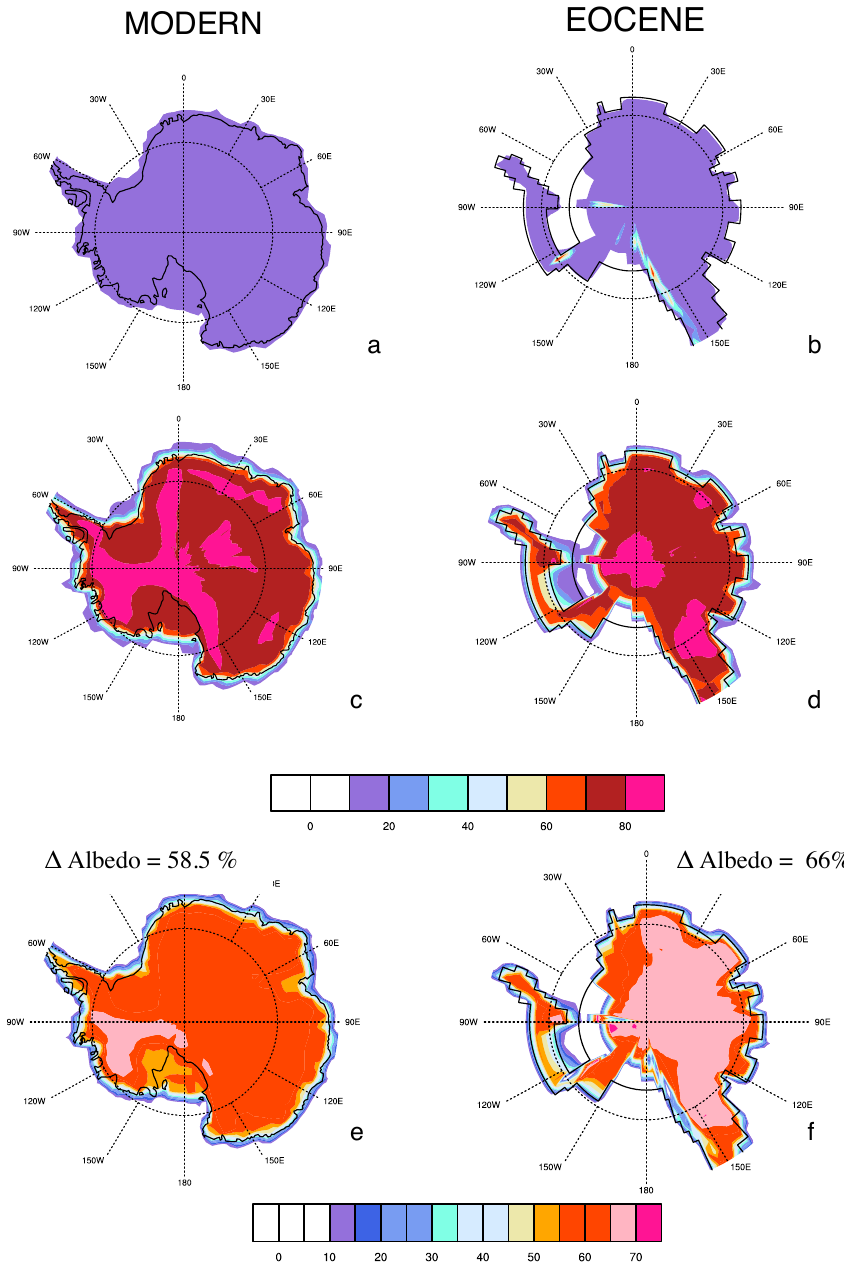
Figure 3. Surface albedos (%) for Modern and Eocene glaciated and unglaciated simulations averaged over the Fig. 3. Surface albedos (%) for modern and Eocene glaciated ( α +oro) and unglaciated simulations averaged over the austral summer at austral summer at 2240 ppm CO 2 . a) Modern unglaciated simulation, b) Eocene unglaciated simulation, c) Modern 2240ppm CO 2 . (a) Modern unglaciated simulation, (b) Eocene unglaciated simulation, (c) modern glaciated simulation, (d) Eocene glaciated simulation, (e) modern glaciated versus unglaciated, and (f) Eocene glaciated versus glaciated simulation, d) Eocene glaciated simulation, e) Modern glaciated versus unglaciated, f) Eocene glaciated versus unglaciated (f).